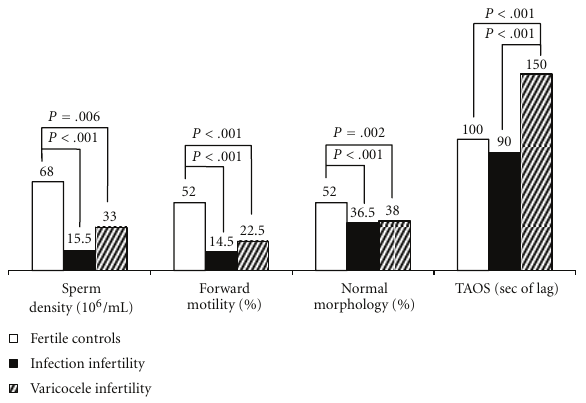
Figure 1: Standard sperm analysis and total antioxidant status (values are medians; data from